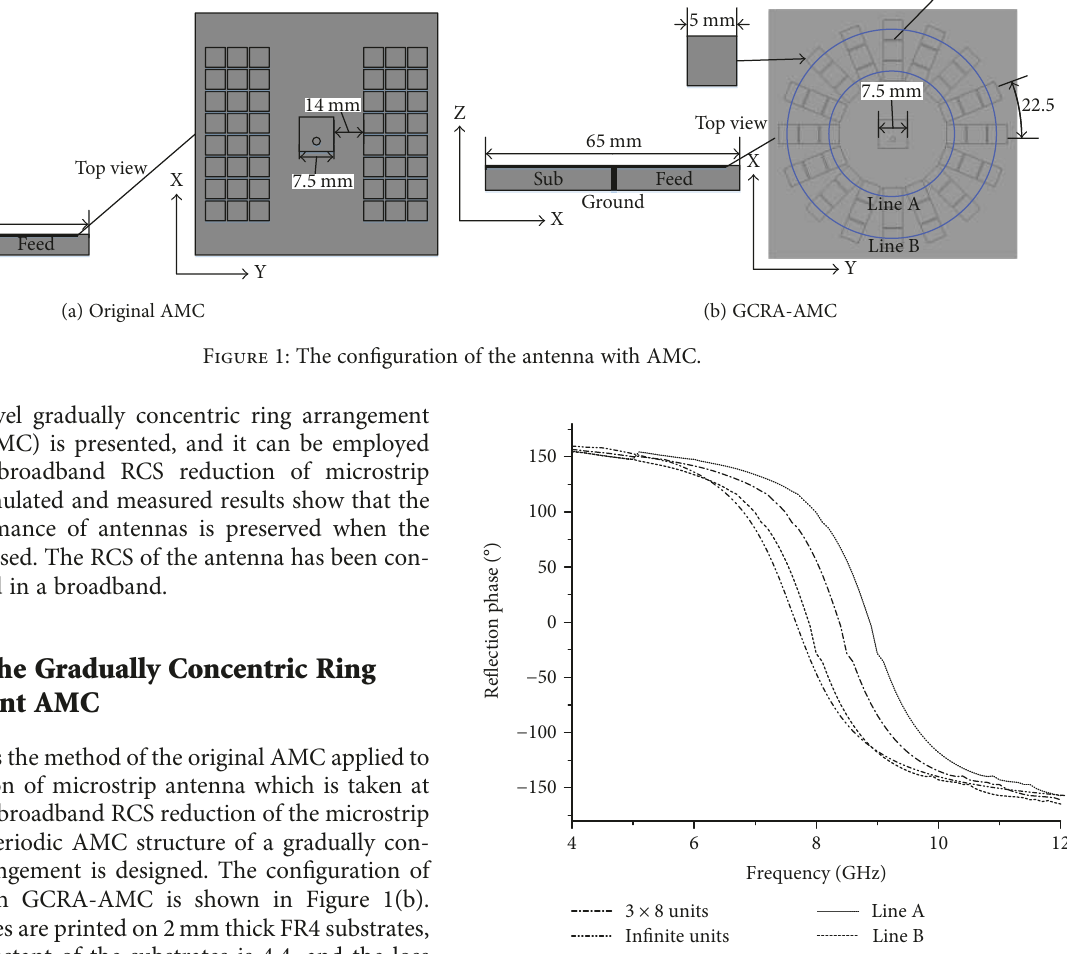
Figure 2: The simulated re fl ection